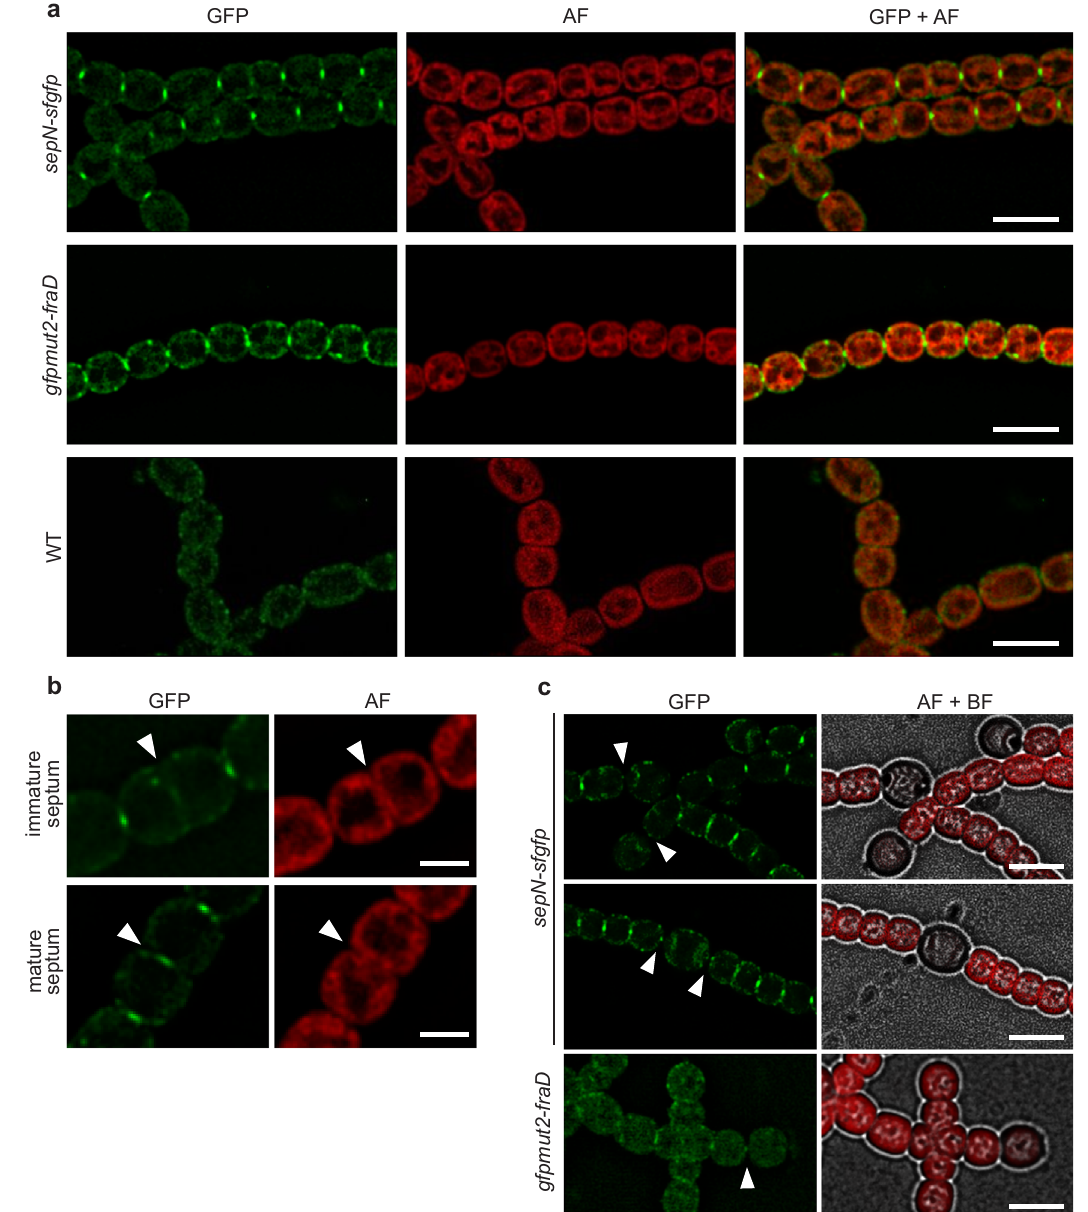
Fig.1|SepNlocalizestotheseptum.a Green fl uorescentfociofSepN-sfGFPwere detected in the septum between vegetative cells. The localization of fl uorescent foci is similar to GFPmut2-FraD. WT cells were included as a negative control. Shown are fl uorescence micrographs of GFP, auto fl uorescence (AF) coming from thephotosyntheticpigments,andanoverlayofboth.Bars,5 µ m. b No fl uorescence couldbedetectedforSepN-sfGFPinimmatureseptaofdividingcellsbutappeared